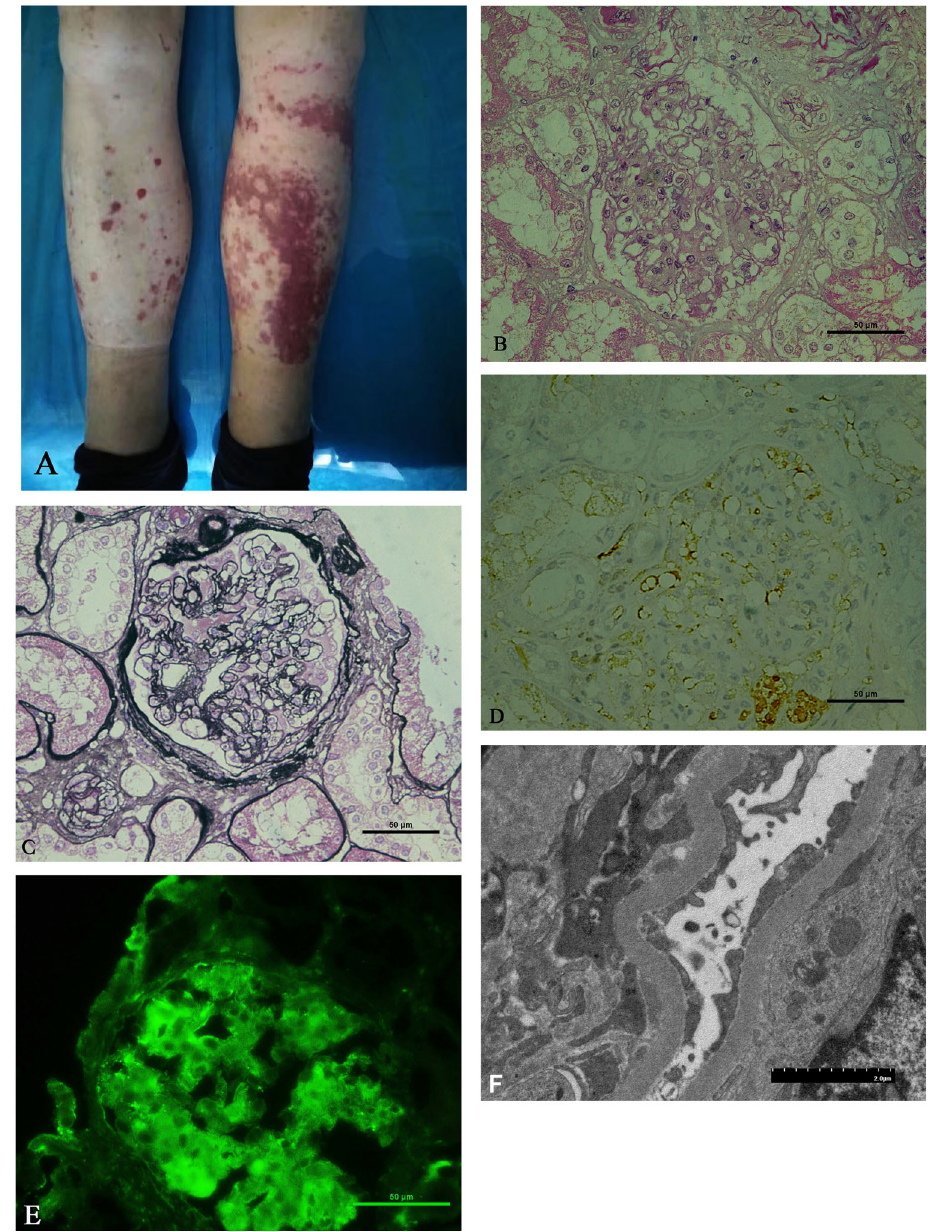
Figure 1. Skin purpura and kidney biopsy. A , Lower extremity purpura. B , Hematoxylin and eosin stain showing glomerular necrosis ( (cid:1) 400). C , Periodic Schiff-Methenamine stain showing proliferation of mesangial cell and mesangial matrix ( (cid:1) 400). D , Positive staining with k -light chain in the glomeruli and renal tubular epithelial cells ( (cid:1) 400). E , Con fl uent, granular staining of mesangial IgA deposits ( (cid:1) 400). F , Electron microscopy demonstrating the electron-dense deposits in the mesangial region ( (cid:1) 5000). Scale bars in B , C , D , E : 50 m m; scale bar in F : 2 m